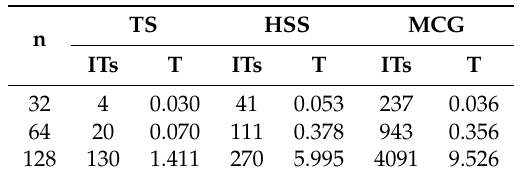
Table 1. Comparison of the the number of iteration steps (ITs) and the computational time in seconds (T) when choosing r = 0.01. HSS: Hermitian and skew-Hermitian splitting; MCG: modified conjugate gradient method; TS: two-stage iteration.